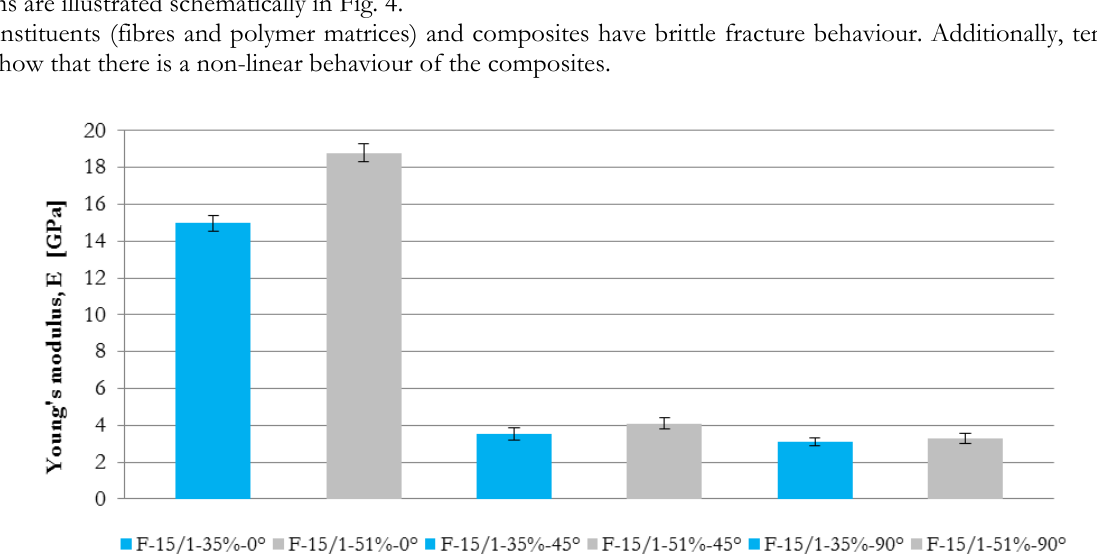
Figure 3: Young’s moduli of unnotched specimens.